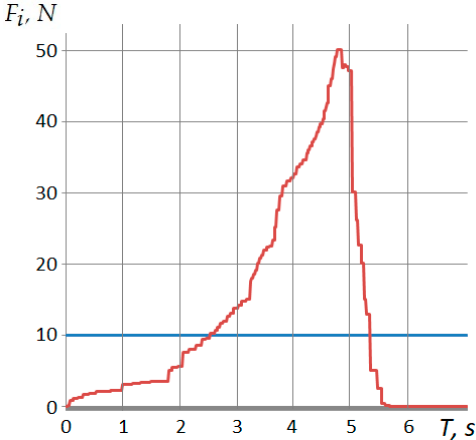
Figure 10. The oscillogram for determining the limit value of the fixation force.